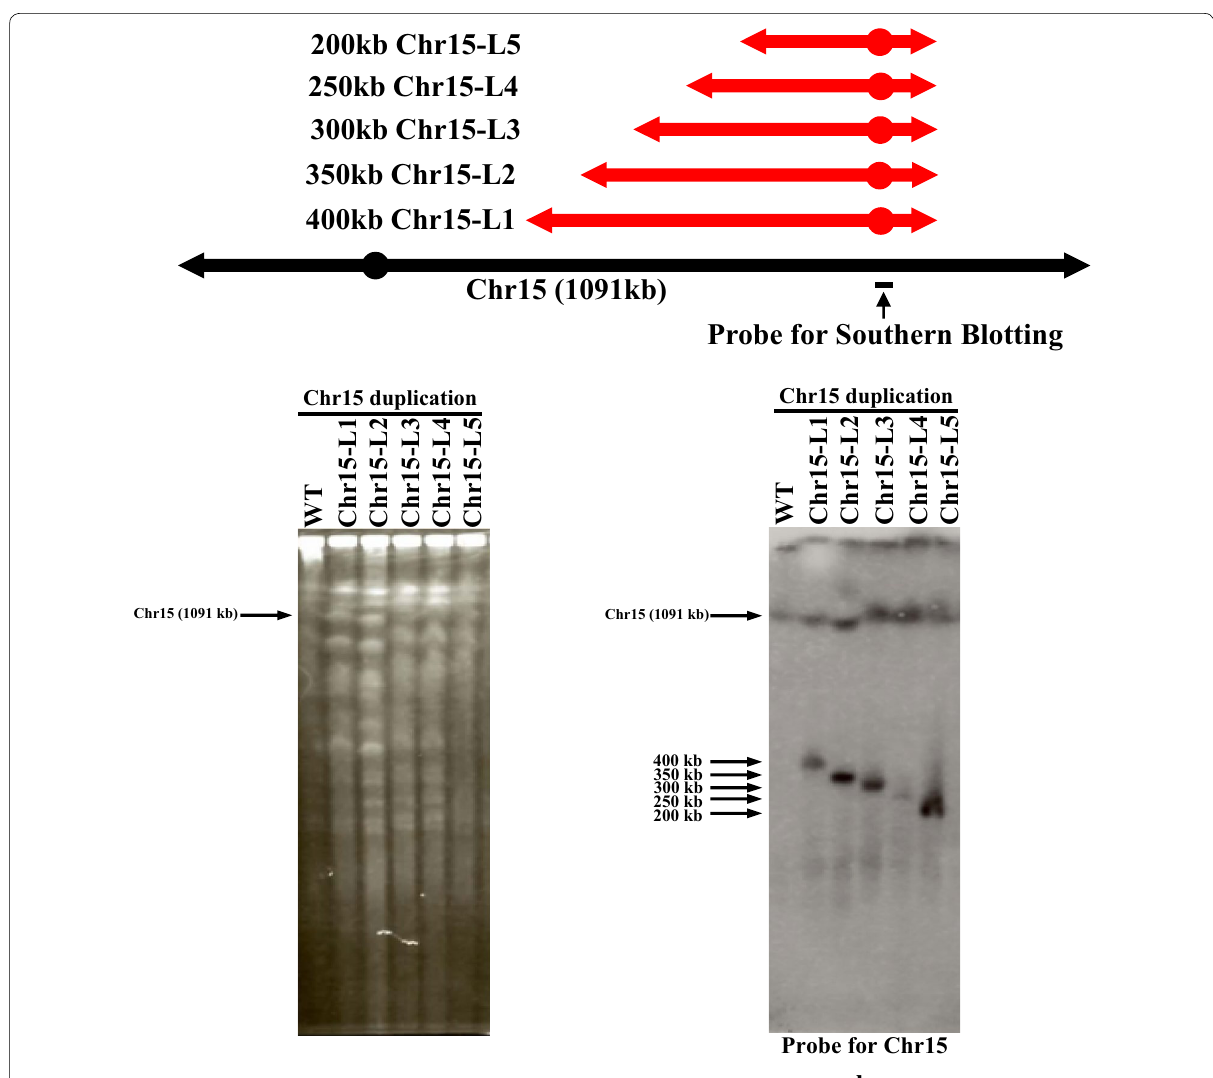
Fig. 5 Duplication of the 200 kb to 400 kb chromosomal region in Chr15. Region Chr15-L1 to Chr15-L5 of Chr15 were selected. All the duplicating modules were marked with CgHIS3 along with CEN4 and CgLEU2 . Fig. 5 a represents PFGE analysis of wild type SJY30 and transformants obtained from the duplication experiments for the Chr15-L1, Chr15-L2, Chr15-L3, Chr15-L4 and Chr15-L5 regions by CRISPR-PCDup. Fig. 5 b shows the results of Southern blot analysis after PFGE for the detection of the newly generated 400 kb, 350 kb, 300 kb, 250 kb and 200 kb chromosomes,